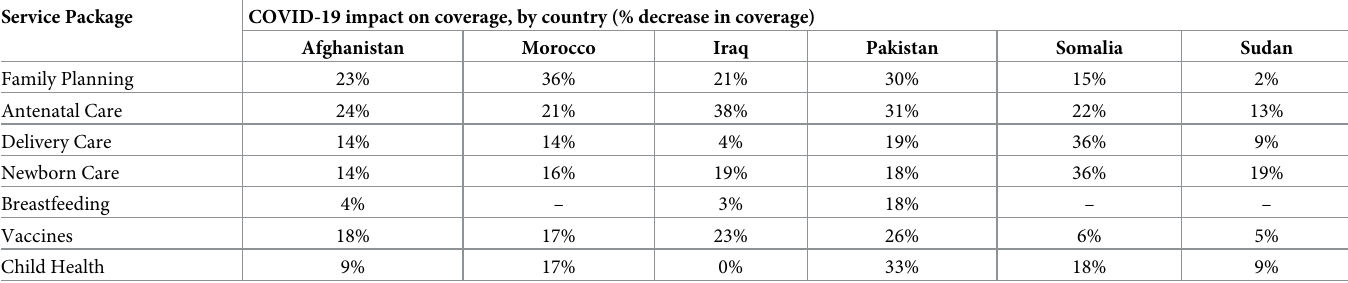
Table 2. Estimated average coverage disruptions from March to August 2020 applied to the year of 2020 by service package by country and included in the analysis. Service Package COVID-19 impact on coverage, by country (% decrease in